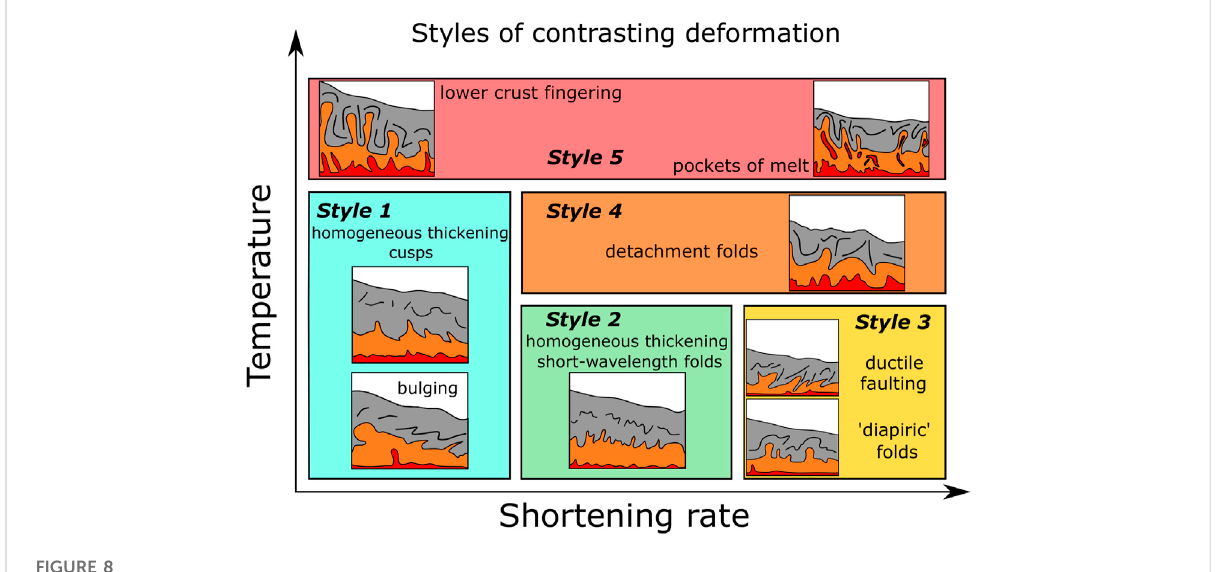
FIGURE 8 Styles of characteristic deformation corresponding to fi elds in V-T matrix.